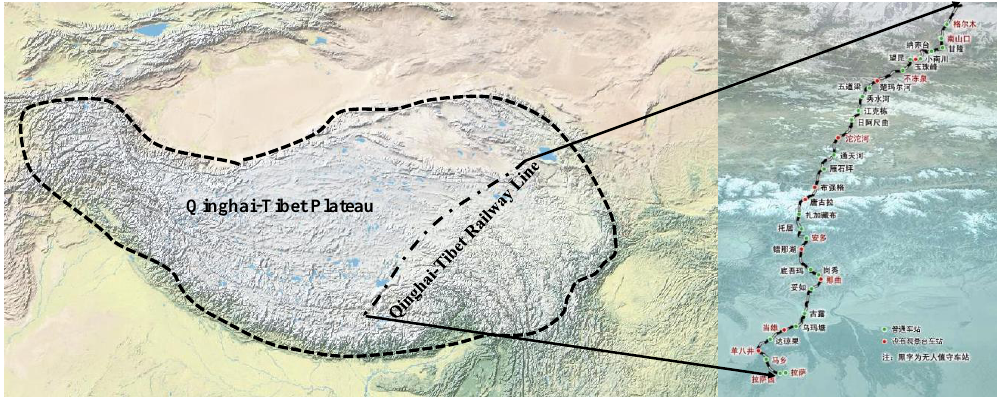
Figure 1. Qinghai–Tibet Plateau, China, and the Qinghai–Tibet railway line. (格尔木- Golmud Railway Station , 南山口- Nanshankou Railway Station , 甘隆- Ganlong Railway Station , 纳赤台 - Nachitai Railway Station , 小南川- Xiaonanchuan Railway Station ,玉珠峰- Yuzhu Peak Railway Station , 望昆- Wangkun Railway Station , 不冻泉- Unfreezing spring Railway Station ,楚玛尔河 - Chumar River Railway Station , 五道梁- Wudaoliang Railway Station ,秀水河- Xiushuihe Railway Station , 江克栋- Jiangkedong Railway Station , 日阿尺曲- Riachiqu Railway Station , 沱沱河- Ulan Moron Railway Station , 通天河- Tongtian River Railway Station ,雁石坪- Yanshiping Railway Station , 布强格 - Buqiangge Railway Station , 唐古拉- Tanggula Railway Station , 扎加藏布- Za’gya Zangbo Railway Station ,托居 - U-nyok Chu Railway Station ,安多 - Anduo Railway Station ,错那湖 - Cona Lake Railway Station ,底吾玛 - Diwuma Station , 岗秀 - Gangxiu Station , 那曲- Naqu Railway Station , 妥如-T uoru Station , 古露- Gulog Railway Station , 乌玛塘 - U-ma Thang Railway Station ,当 雄- Dangxiong Railway Station , 达琼果- Dhachu-go Railway Station , 羊八井- Yangbajing Railway Station , 马乡- Maxiang Railway Station, 拉萨西- Lhasaxi Railway Station , 拉萨- Lasa Railway Station , 普通车站- Ordinary station , 设有观景台车站- Observation deck station , 注：黑字为无人值守车站- Note: Black letters indicate unattended stations ).